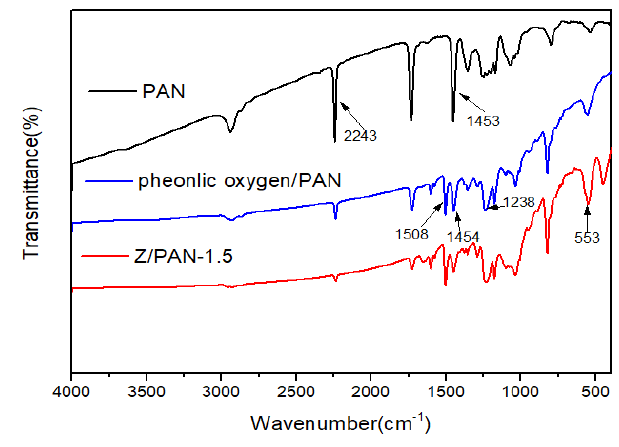
Figure 1. FT-IR spectra of electrospun PAN separator, phenoxy resin/PAN separator, and Z/PAN- 1.5 separators.